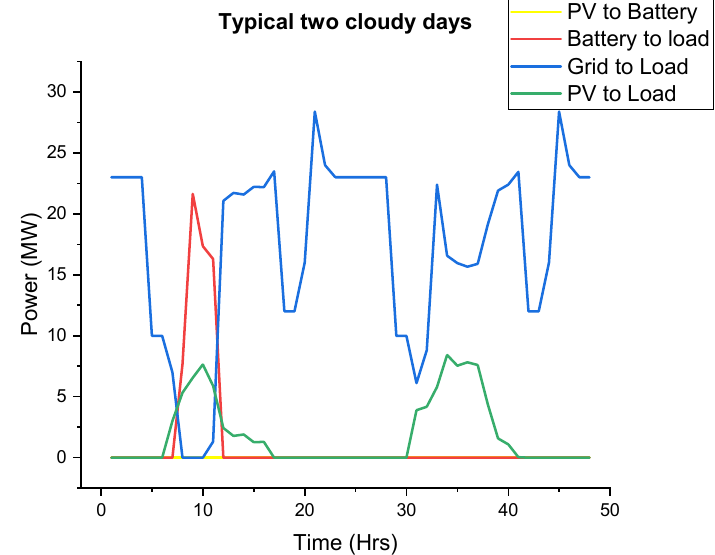
Figure 17. Two typical consecutive days with bad PV production.